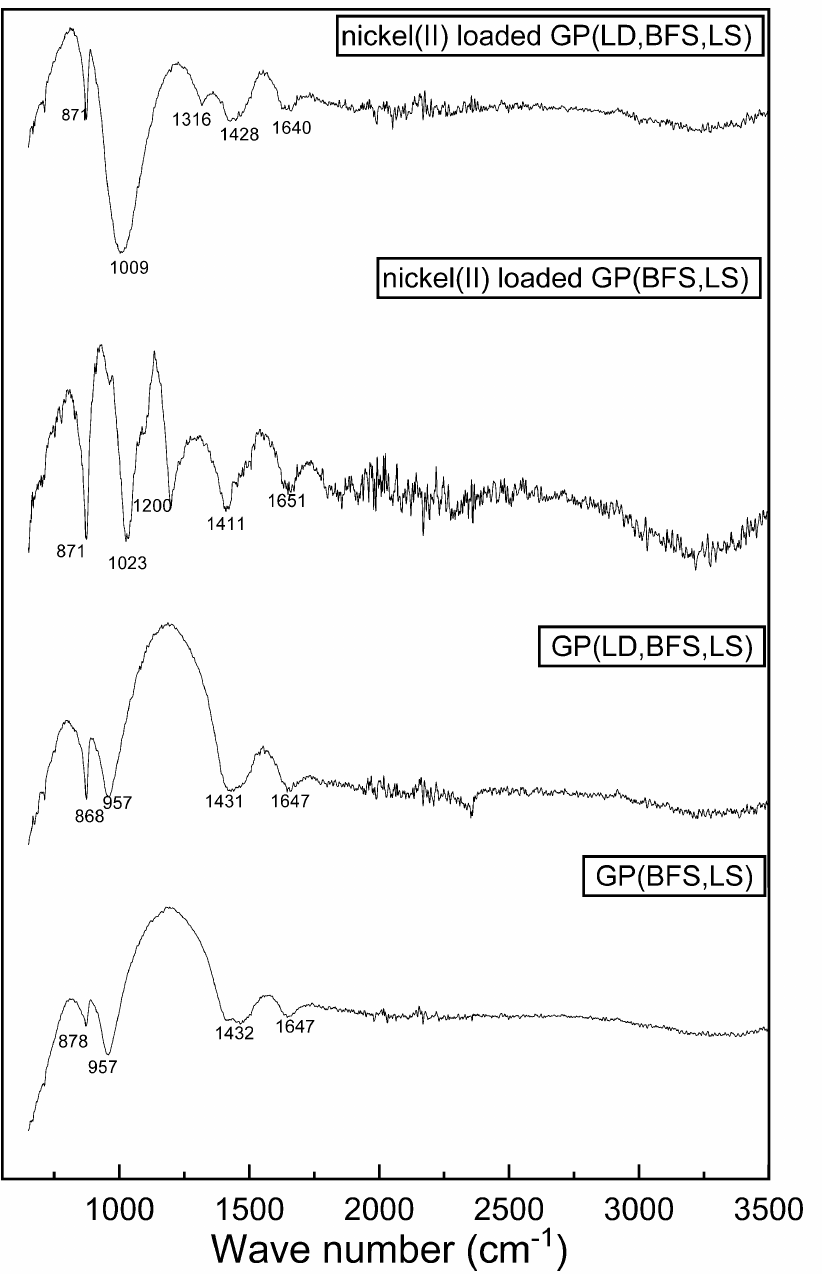
Figure 3. Fourier transform infrared (FTIR) spectra of GP (BFS, LS), GP (LD, BFS, LS), nickel(II) loaded GP (BFS, LS), and nickel(II) loaded GP (LD, BFS, LS). The slag-based geopolymers GP (BFS, LS) and GP (LD, BFS, LS) were also imagined by FESEM. Figure 4 shows that geopolymers have a crystalline surface structure due to alkaline activation occurring on the slag surface. This structure is confirmed to have sufficient pores for carrying out the adsorption